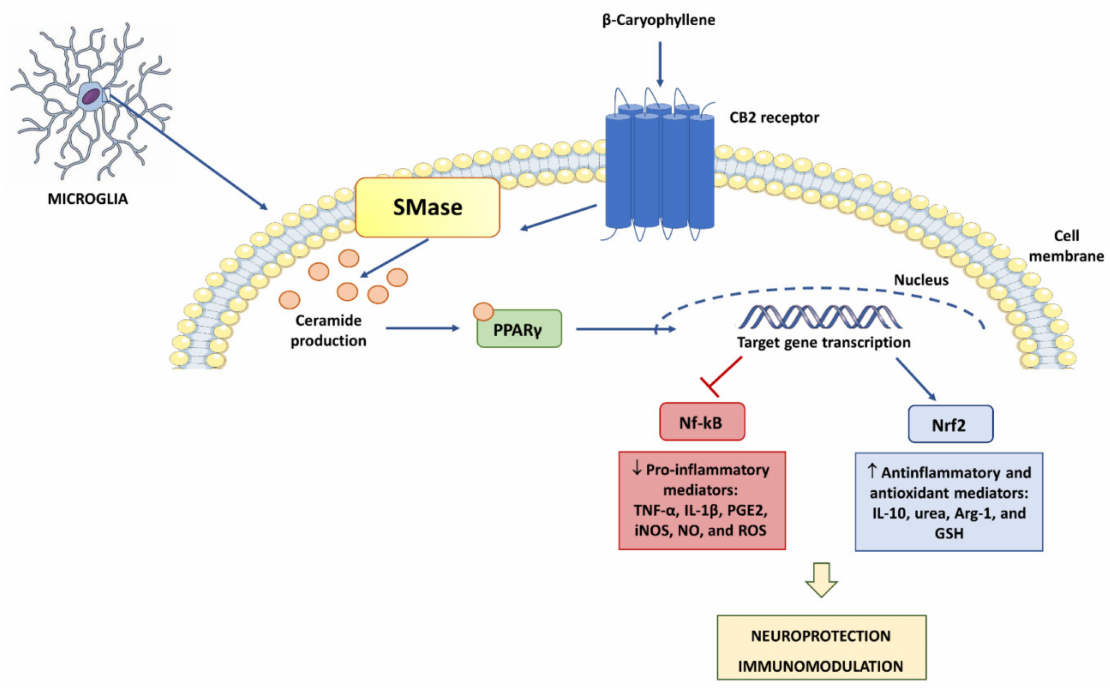
Figure 4. Proposed mechanism underlying the immune-mediated neuroprotective effects of β - caryophyllene via activation of CB2 and PPAR γ receptors through the involvement of ceramides. ↑ increase; ↓